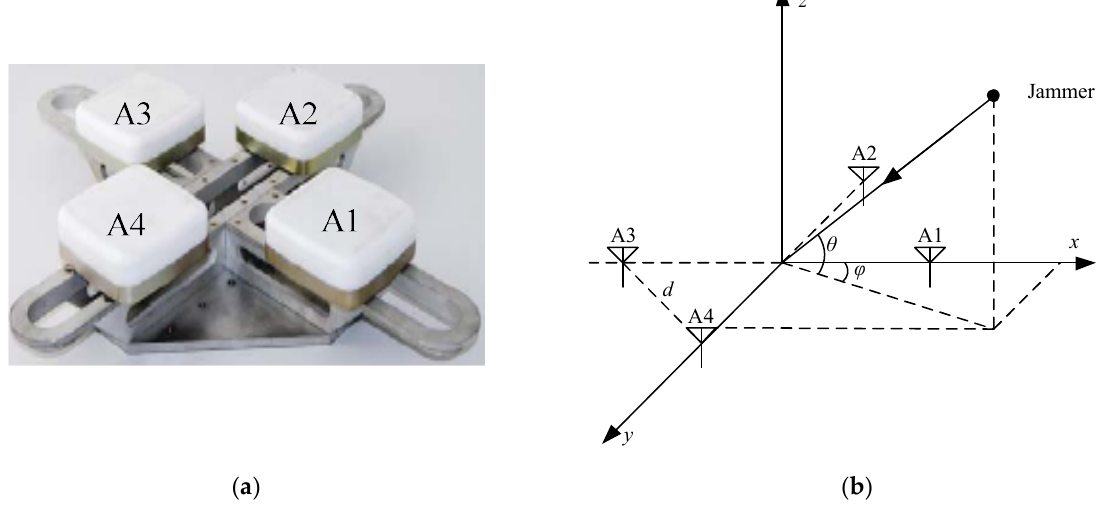
Figure 1. Antenna array ( a ) array picture and ( b ) array model. where θ and ϕ are the pitch and azimuth of jammer or signal; τ ( θ ) is the time delay difference that the jammer or signal reaches to the array center for different elements. If